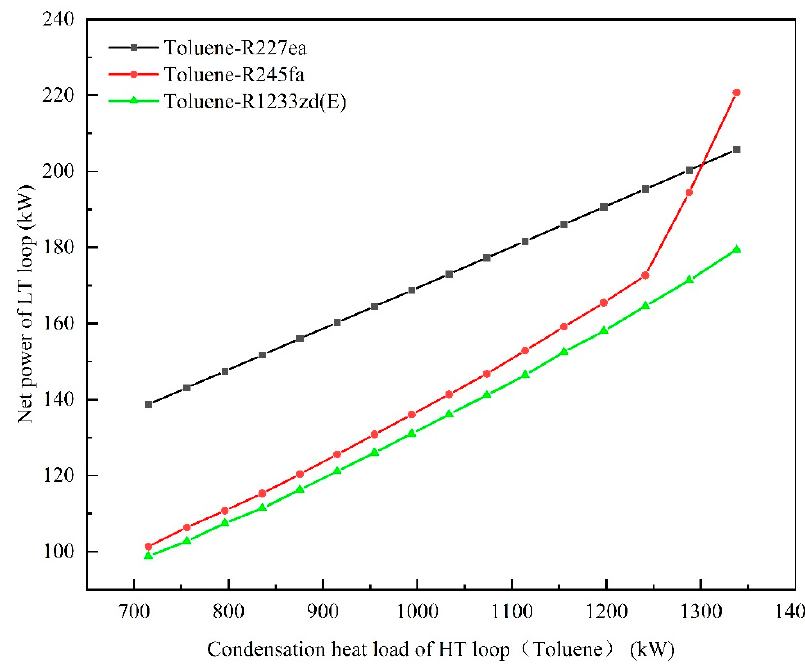
Figure 16. Net power of the LT loop with toluene as the HT loop’s working fluid.